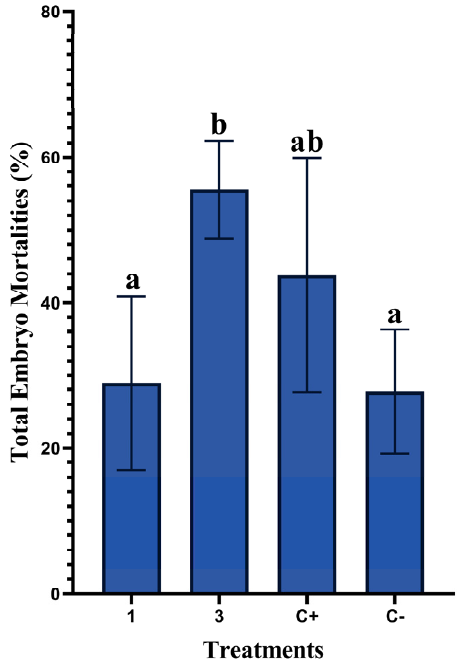
Figure 2. Effects of in ovo administration of different concentrations of rosemary EO on total mortality rates in the non-injected group (C − ), distilled-water-injected group (C+), and treatments with rosemary EO at 1 or 3 µL/egg (five replicates/group). Different letters (a, b) indicate a statistically significant difference ( p < 0.05). Values are represented as mean ± standard error of the mean (SE).